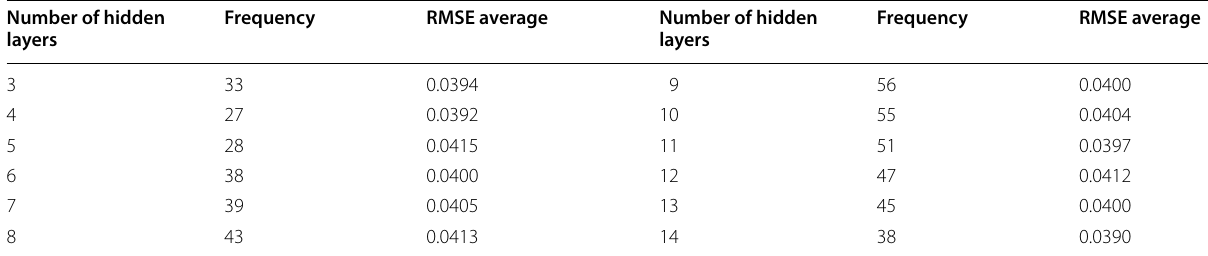
Table 2 Hidden layer number selection Number of hidden layers